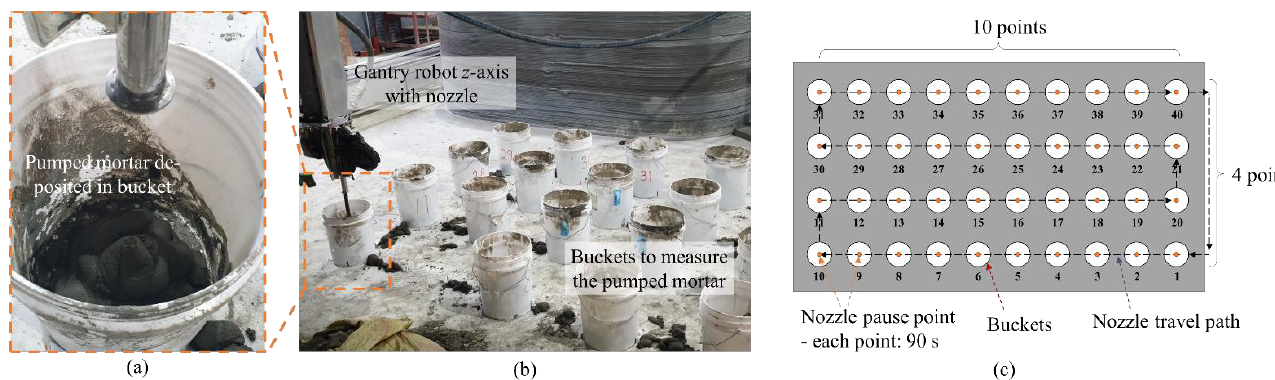
Figure 6. Weight and temperature measurement during pumping test: ( a ) pumped mortar deposited in bucket; ( b ) gantry robot on bucket; ( c ) nozzle travel path.